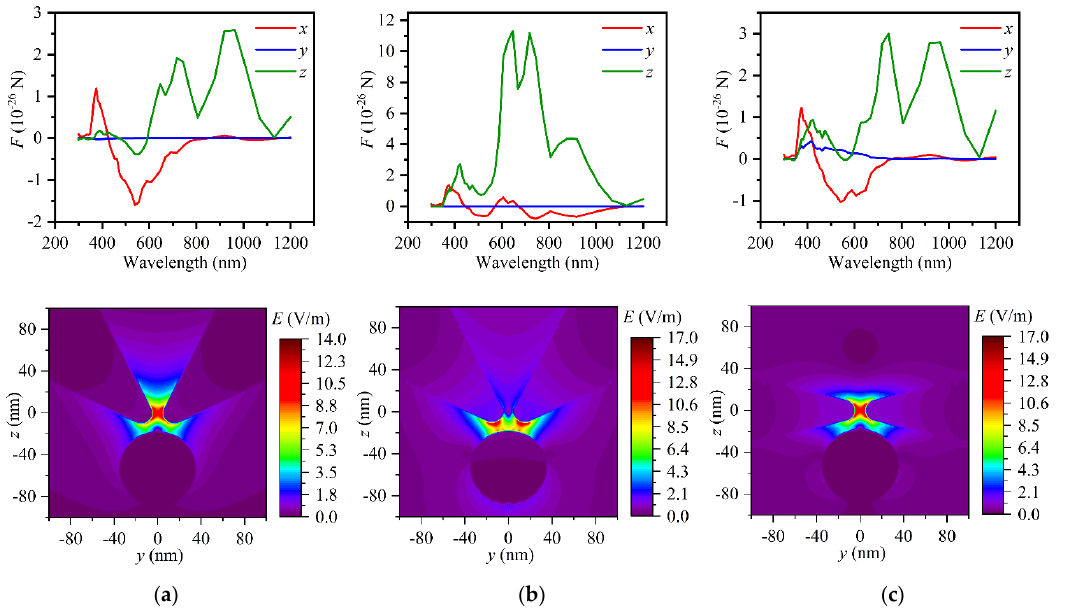
Figure 7. Component forces along x , y , z axis applied on the NP versus wavelength ( top diagram ) and distributions of electric field in y-z plane ( bottom diagram ) around dual probe irradiated by polarized near-field laser. ( a ) ODPs irradiated by HP laser; ( b ) ODPs irradiated by VP laser; ( c ) CDPs irradiated by HP